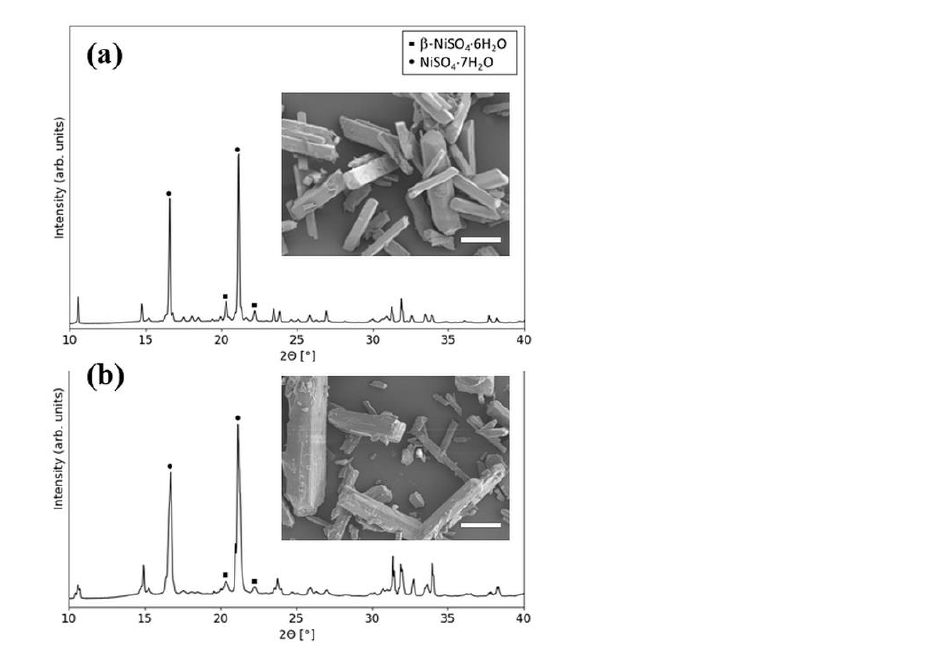
Figure 8. XRD spectra and (insets) SEM images of crystals precipitated at 25 °C ( a ) in the presence of 9 mg g −1 Mg with addition of 2 g seeds, and ( b ) in the presence of 18 mg g −1 Mg, without the addition of seeds. Scale bar: 100 µm.